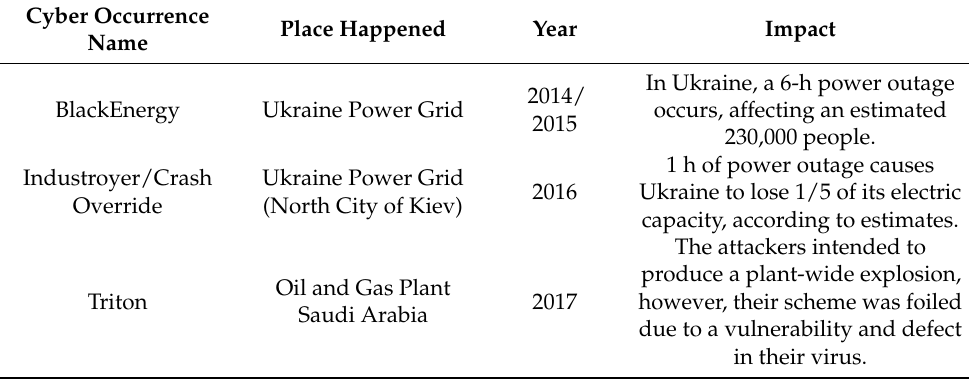
Table 1. Impact of Cyber-Attack.